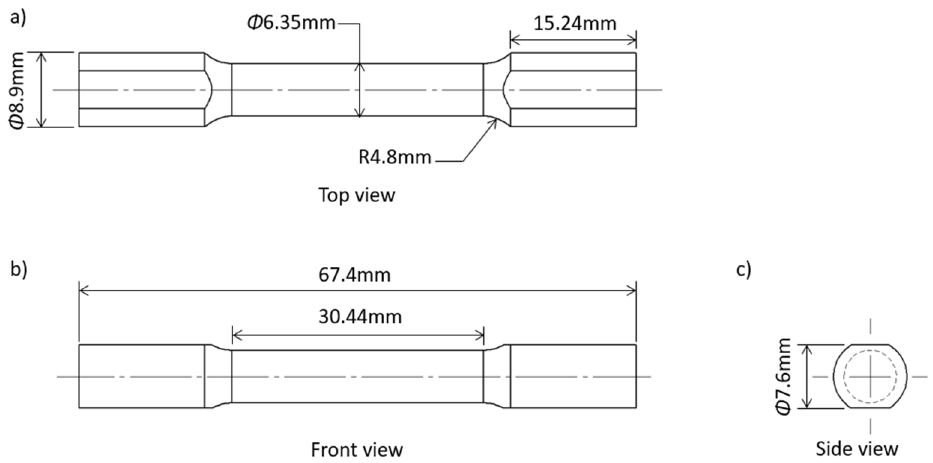
Figure 1. Dimensions of tensile test specimen ( a ) top, ( b ) front, and ( c ) side.